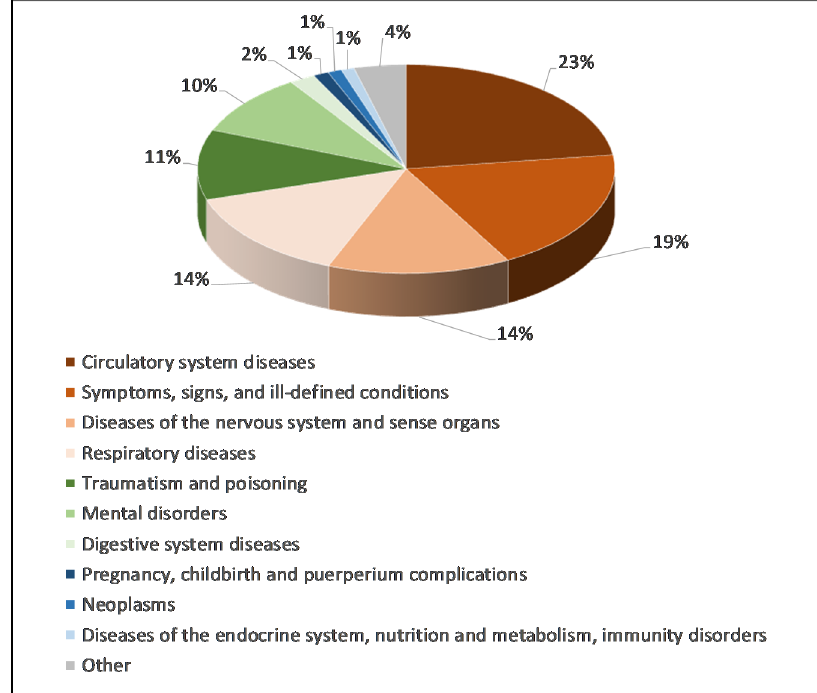
Figure 12. Accesses by cause in code red recorded in 2011 by the Policlinico Umberto I emergency room. Source: authors’ elaboration.